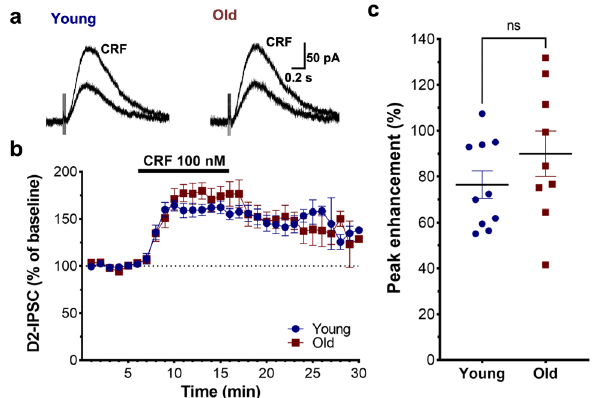
Figure 4. Corticotropin releasing factor (CRF)-induced plasticity is not affected by age. ( a ) Traces from young and old mice depicting representative D2-IPSCs at baseline and after bath application of CRF (100 nM). ( b ) Normalized time course of response to bath-application (horizontal bar) showed no effect of age. ( c ) There was no difference in peak enhancement of D2-IPSCs by CRF in old versus young male